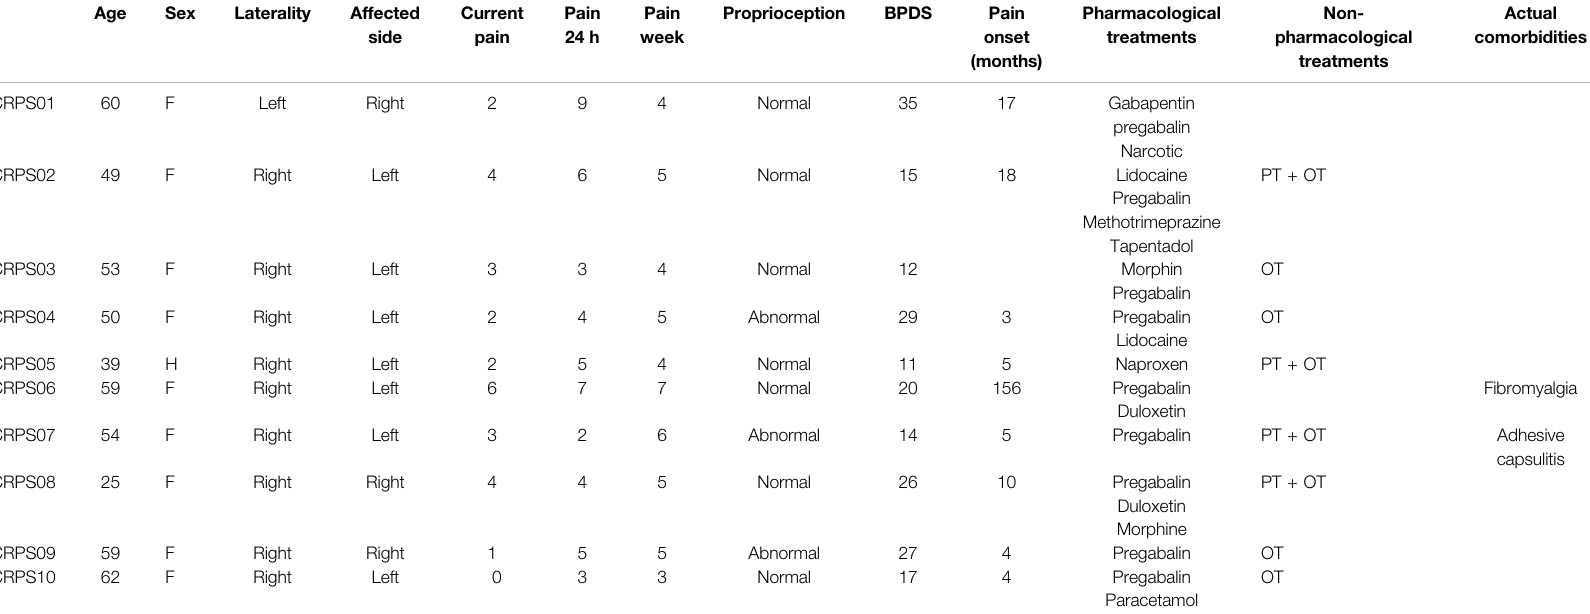
TABLE 1 | Clinical